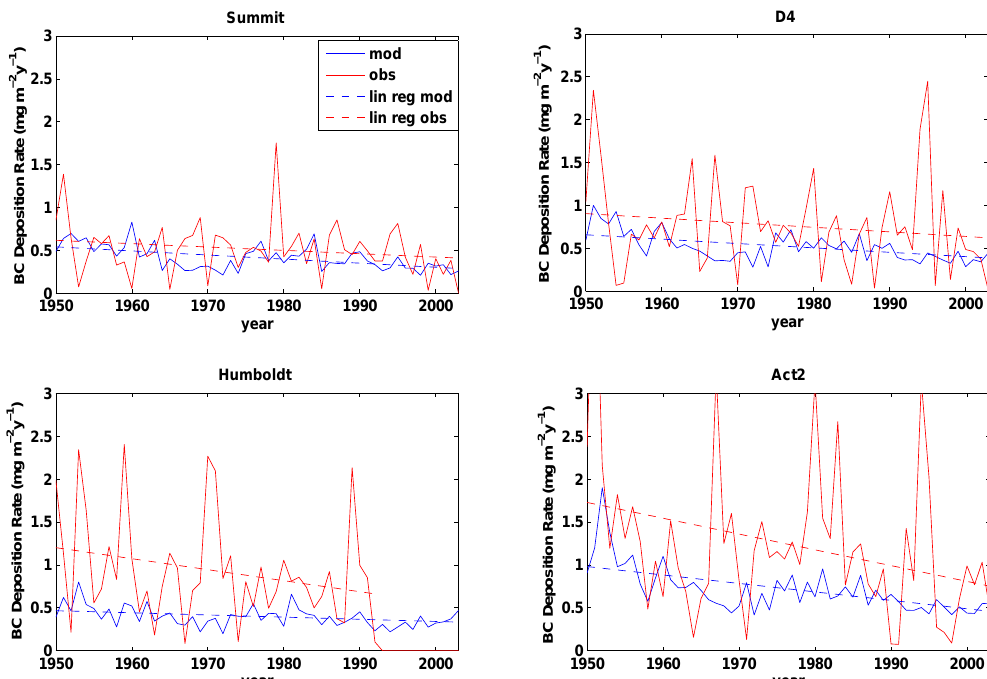
Figure 2. Measured and modelled black carbon (BC) deposition flux in ice cores in Greenland at Summit (72.6 ◦ N, 38.3 ◦ W) (top left), D4 (71.4 ◦ N, 43.9 ◦ W) (top right), Humboldt (78.5 ◦ N, 56.8 ◦ W) (bottom left), and Act2 (66.0 ◦ N, 45.2 ◦ W) (bottom right) from 1950 to 2009. The measurements (solid line) and their linear regression (dashed line) are in red and the model results (solid line) and their linear regression (dashed line) are in blue.